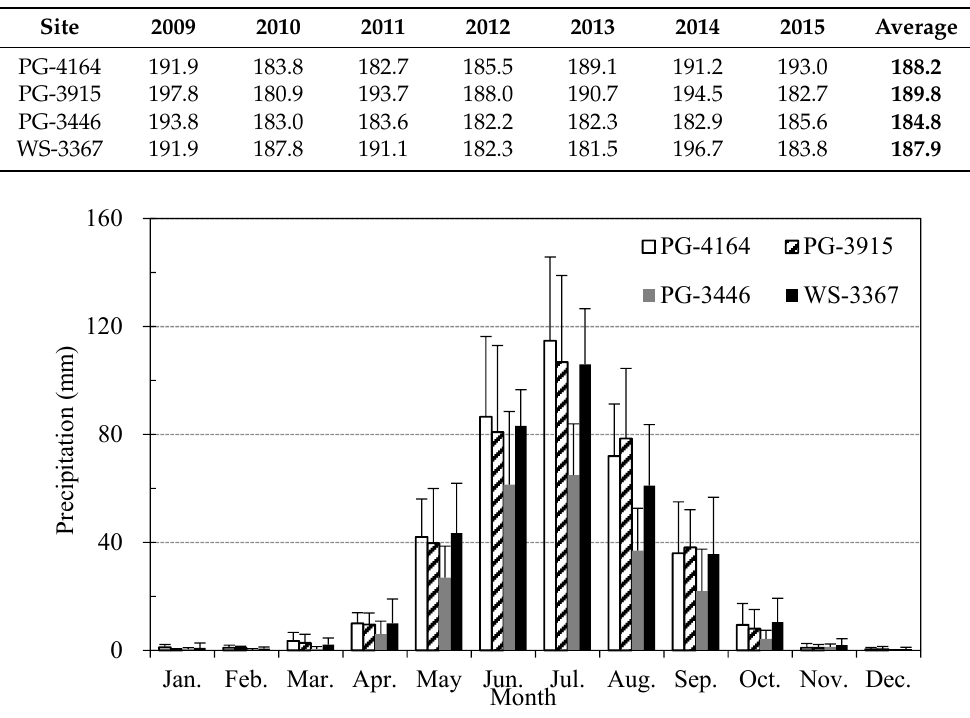
Figure 4. Distribution of average monthly precipitation during 2009–2015. Error bars represent one standard deviation.